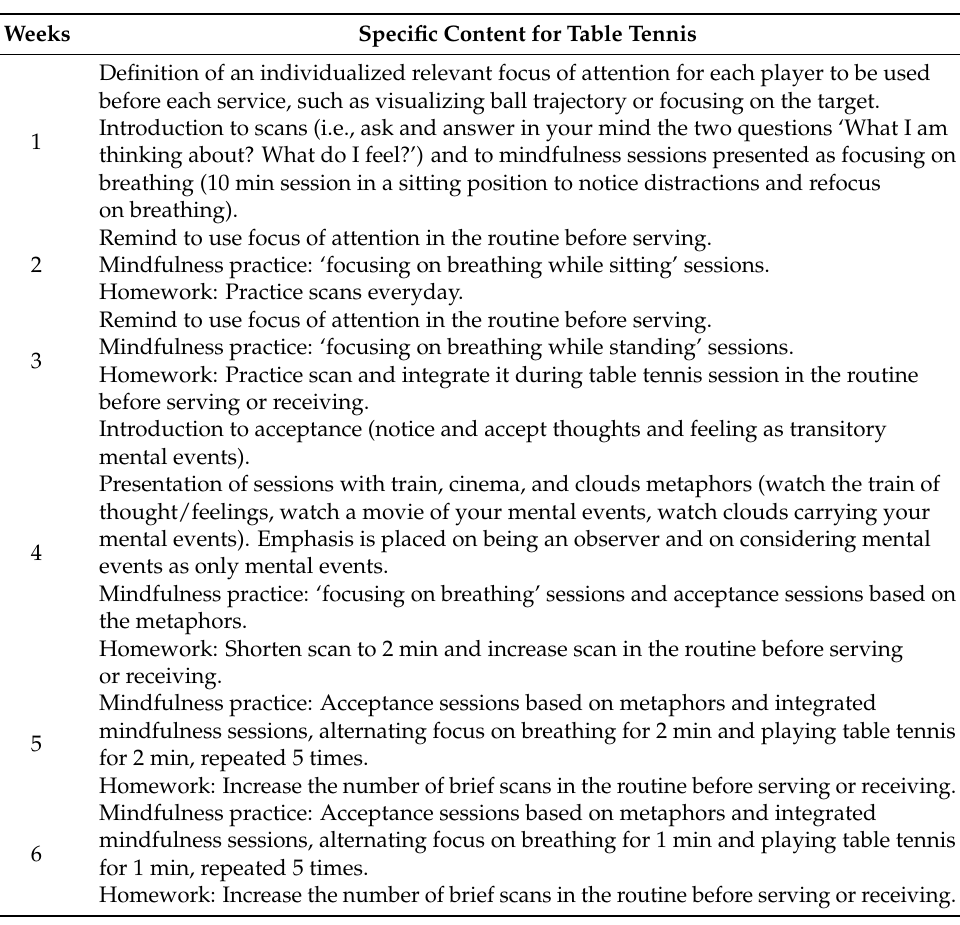
Table 3. Adapted content of the six-week MFP programme in table tennis. Weeks Specific Content for Table